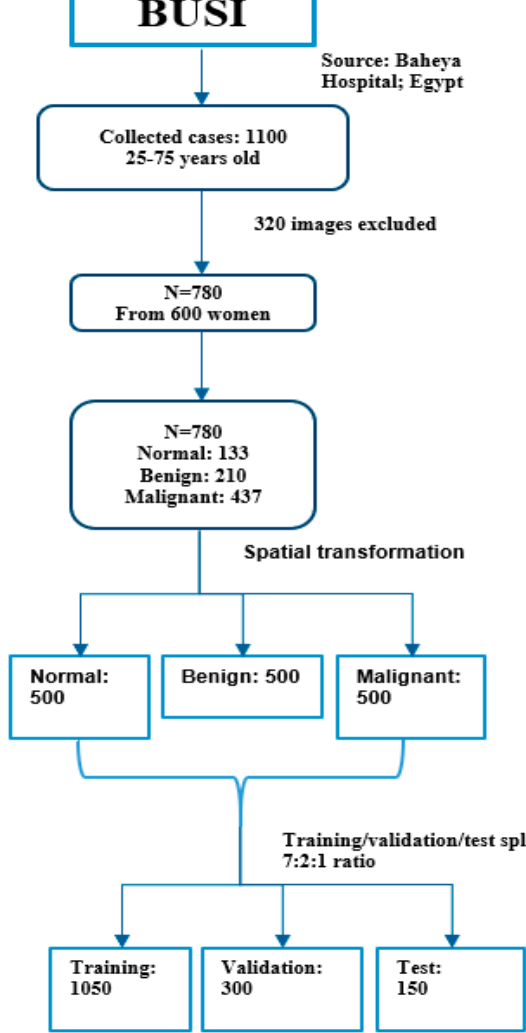
Figure 3. Dataset distribution after preprocessing the BUSI dataset.